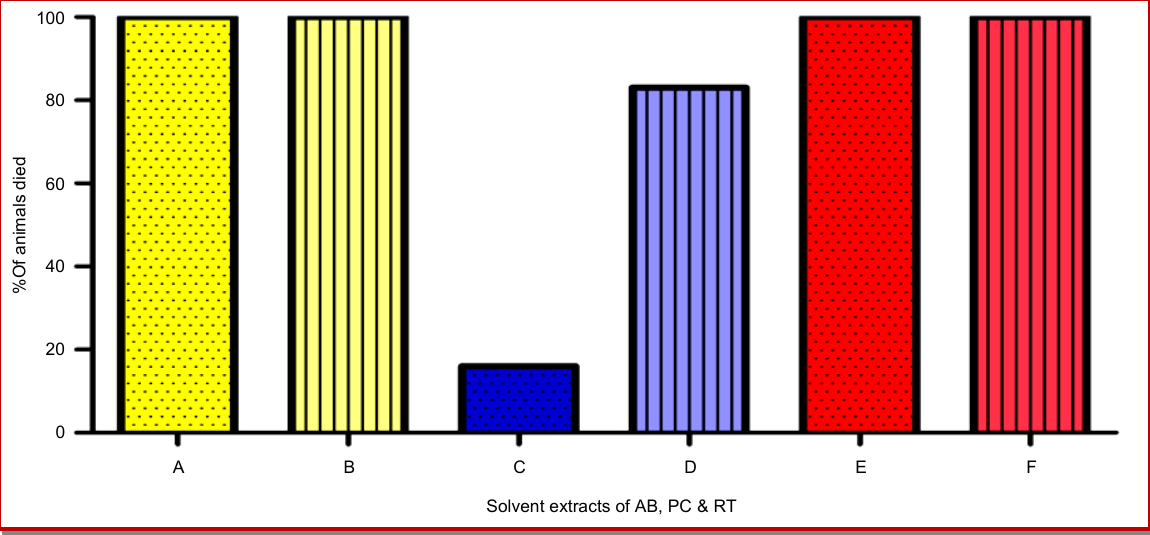
Figure 1: Overall in vivo anti-venom effect of plant extracts (A – aqueous extract of A. bracteolata ; B - Methanol extract of A. bracteolata ; C – aqueous extract of P. cineraria ; D - Methanol extract of P. cineraria ; E – aqueous extract of R. tetraphylla ; F - Methanol extract of R. tetraphylla ) against lethality induced by Naja naja crude venom is schematically represented as observed from the studies of animal models using Swiss albino